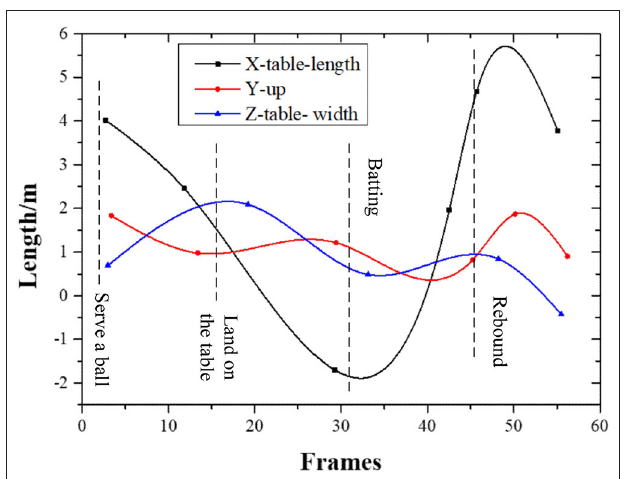
FIGURE 7 | A single-round table tennis trajectory corresponding to slight-spin serve.